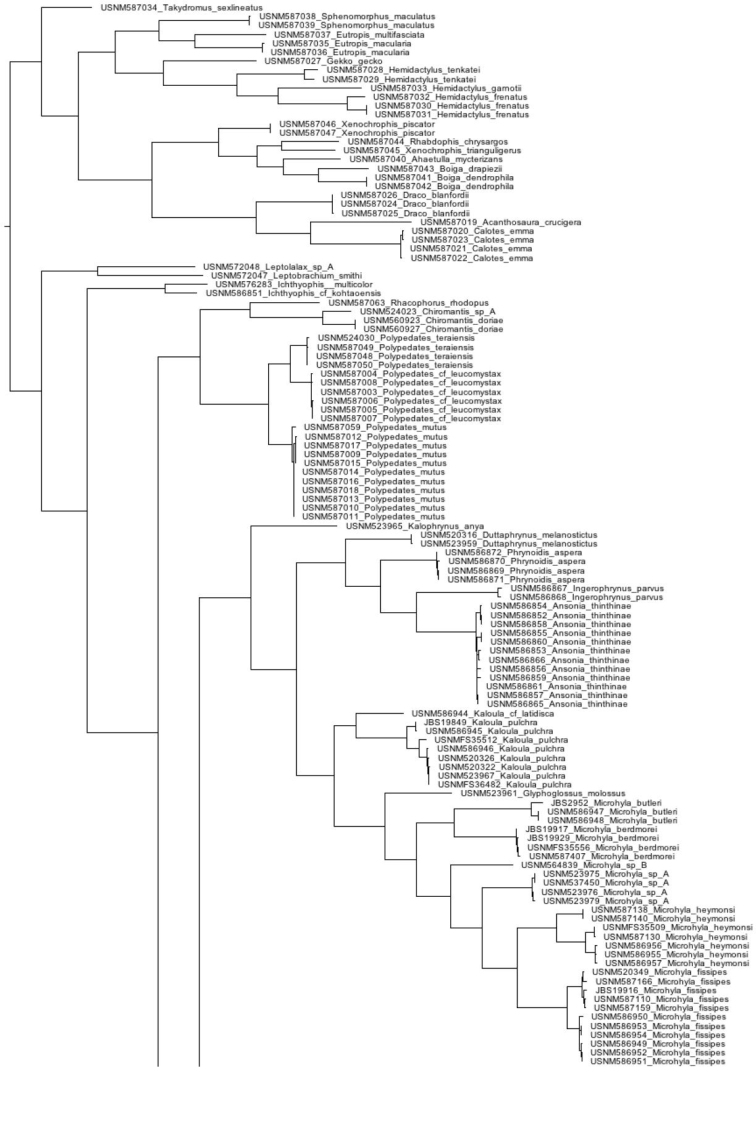
Combined (16S and COI) Neighbor-joining tree for all specimens sequenced in this study.